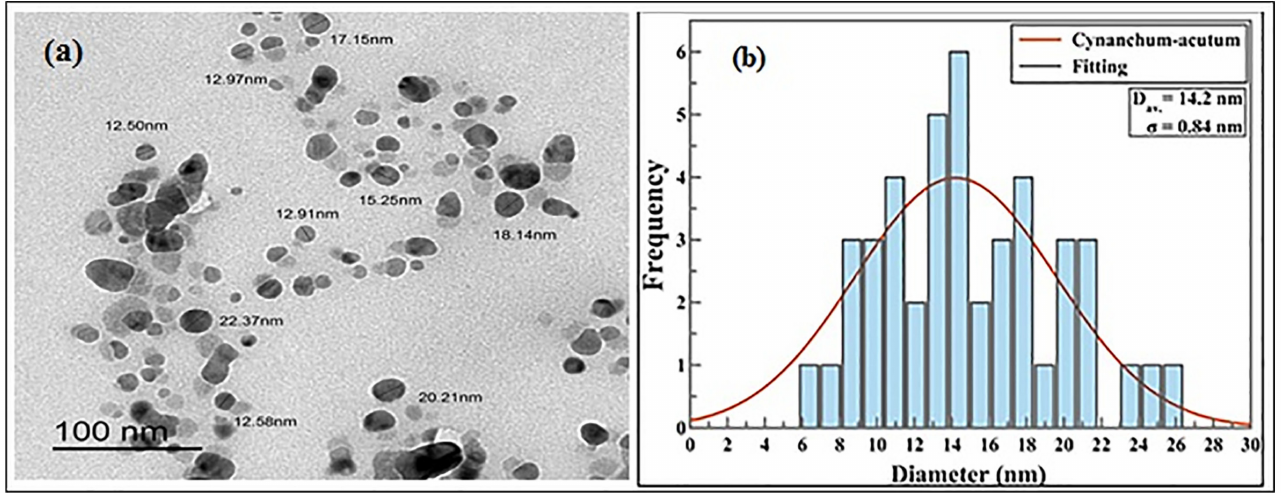
Figure 2. ( a , b ). Transmission electron micrograph of AgNPs synthesized loaded with C. acutum latex (Cy-AgNPs) and histogram of their size